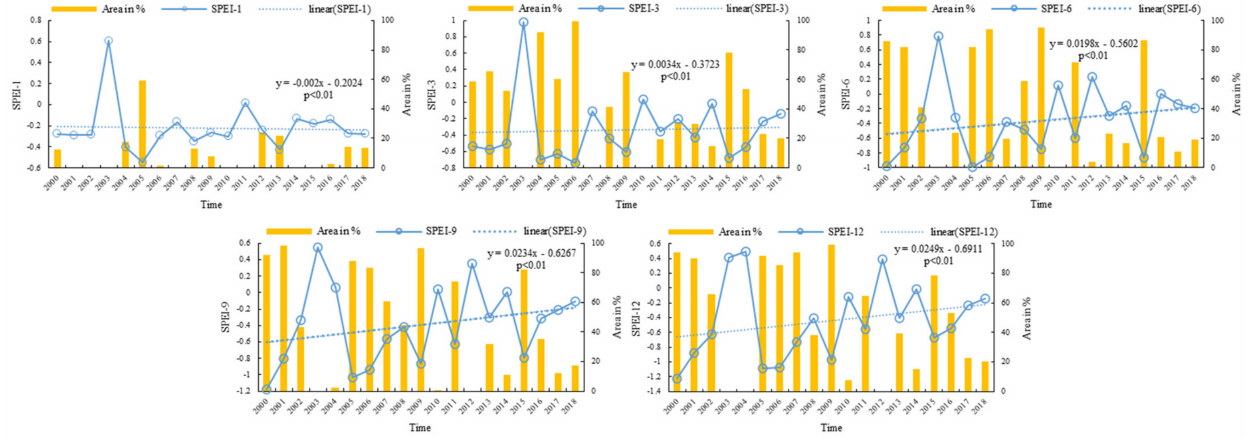
Figure 2. Temporal variation of SPEI at different time scales (blue line) and percentage of arid region areal cover (yellow bars) from 2000 to 2018. Time scales were 1 month (SPEI − 1), 3 months (SPEI − 3), 6 months (SPEI − 6), 9 months (SPEI − 9) and 12 months (SPEI −